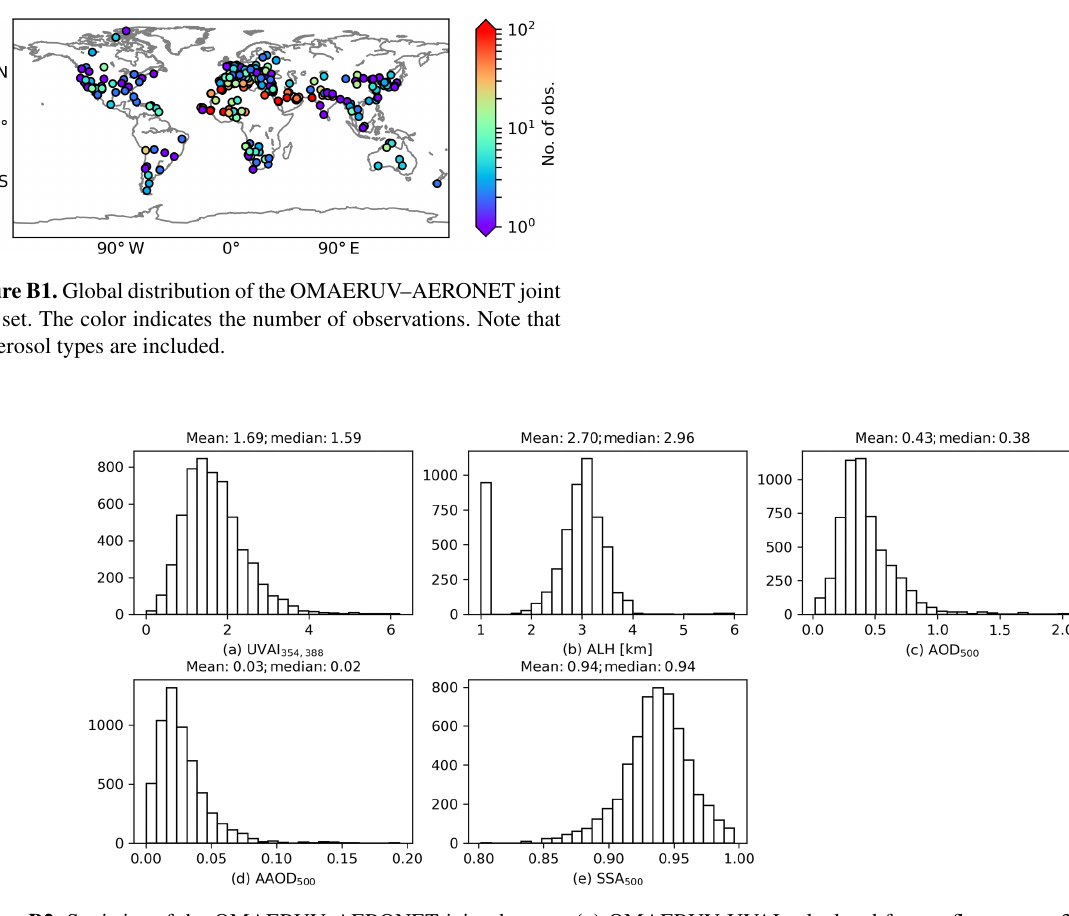
Figure B2. Statistics of the OMAERUV–AERONET joint data set: (a) OMAERUV UVAI calculated from reflectance at 354 and 388nm; (b) OMAERUV ALH; (c) AERONET AOD at 500nm; (d) AERONET AAOD at 500nm; (e) AERONET SSA at